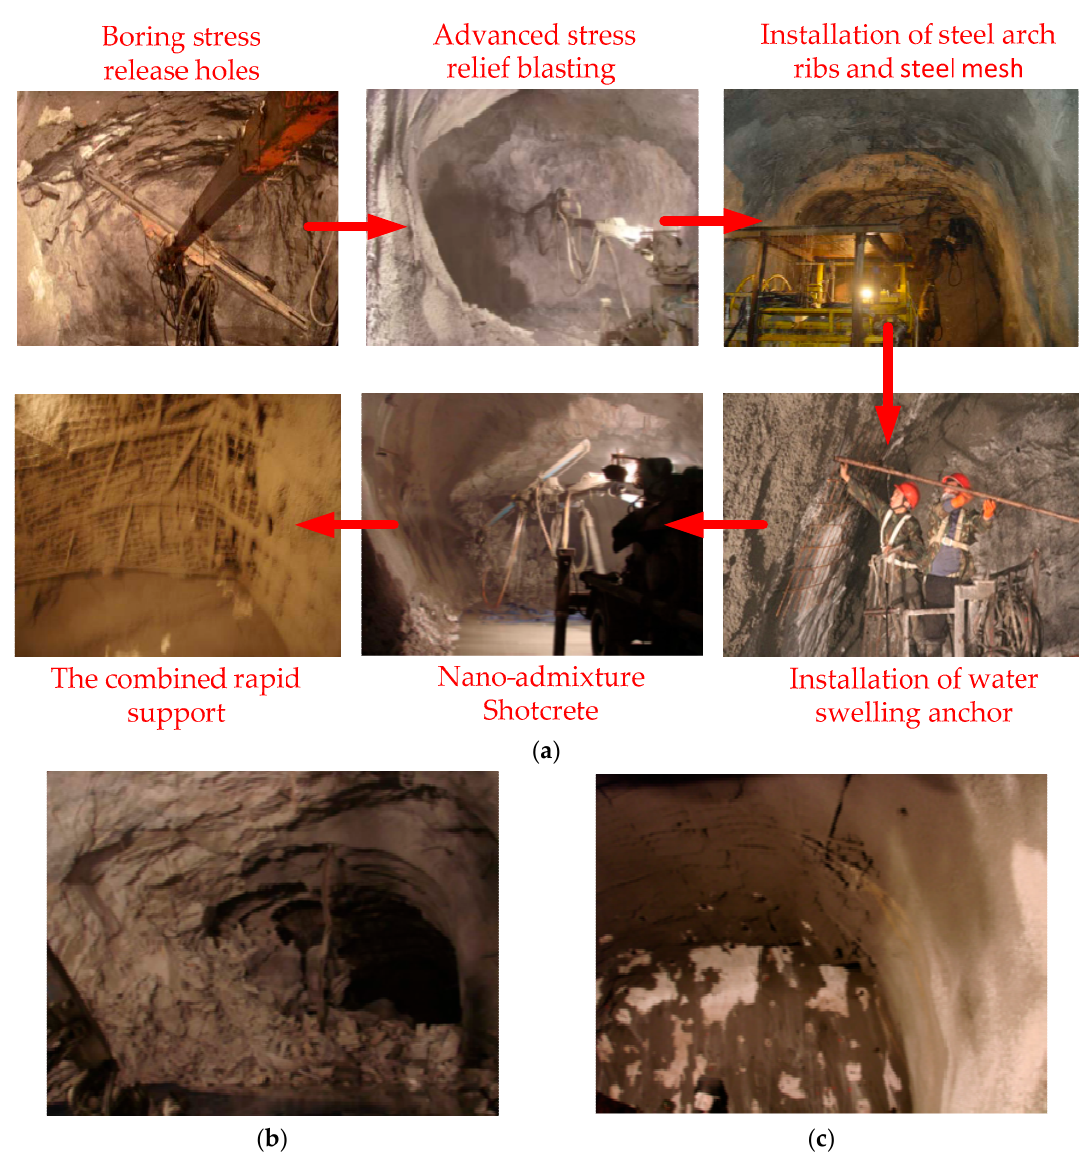
Figure 17. Field application in diversion tunnels: ( a ) Application steps; ( b ) before application and ( c ) after application.